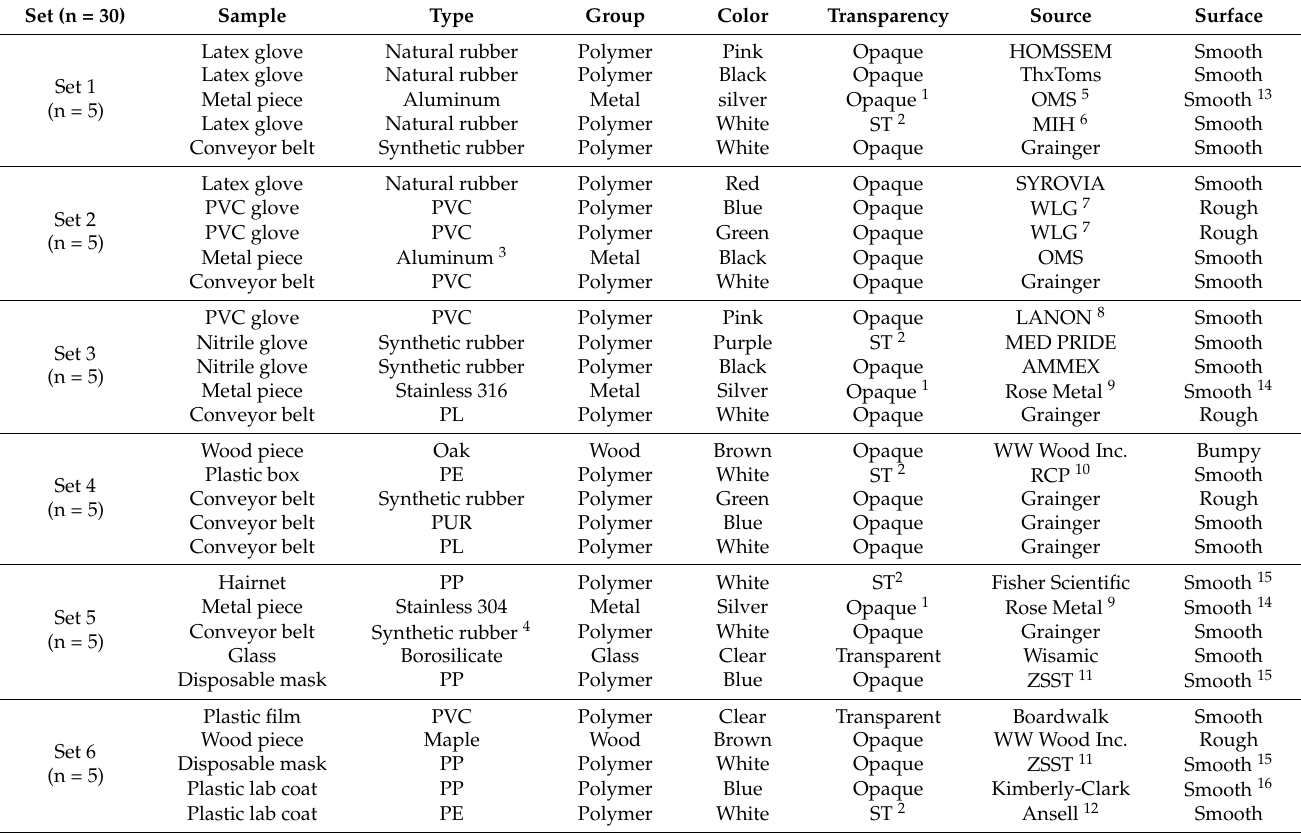
Table 1. List of the FM